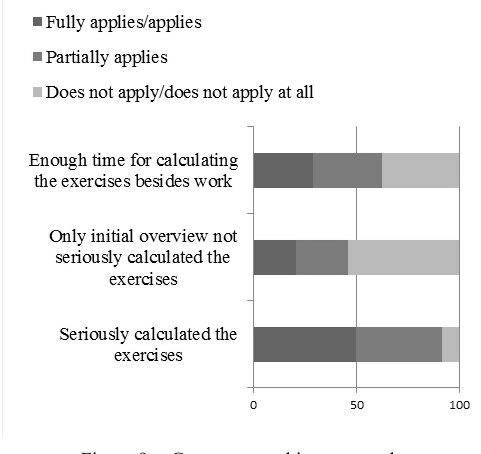
Figure 9. Category: working approach